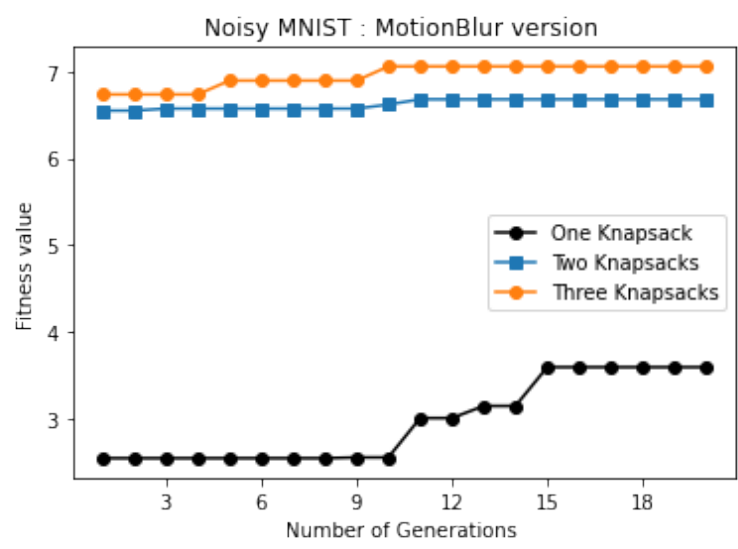
Figure 16. GA fitness vs. the number of generations for motion-blur